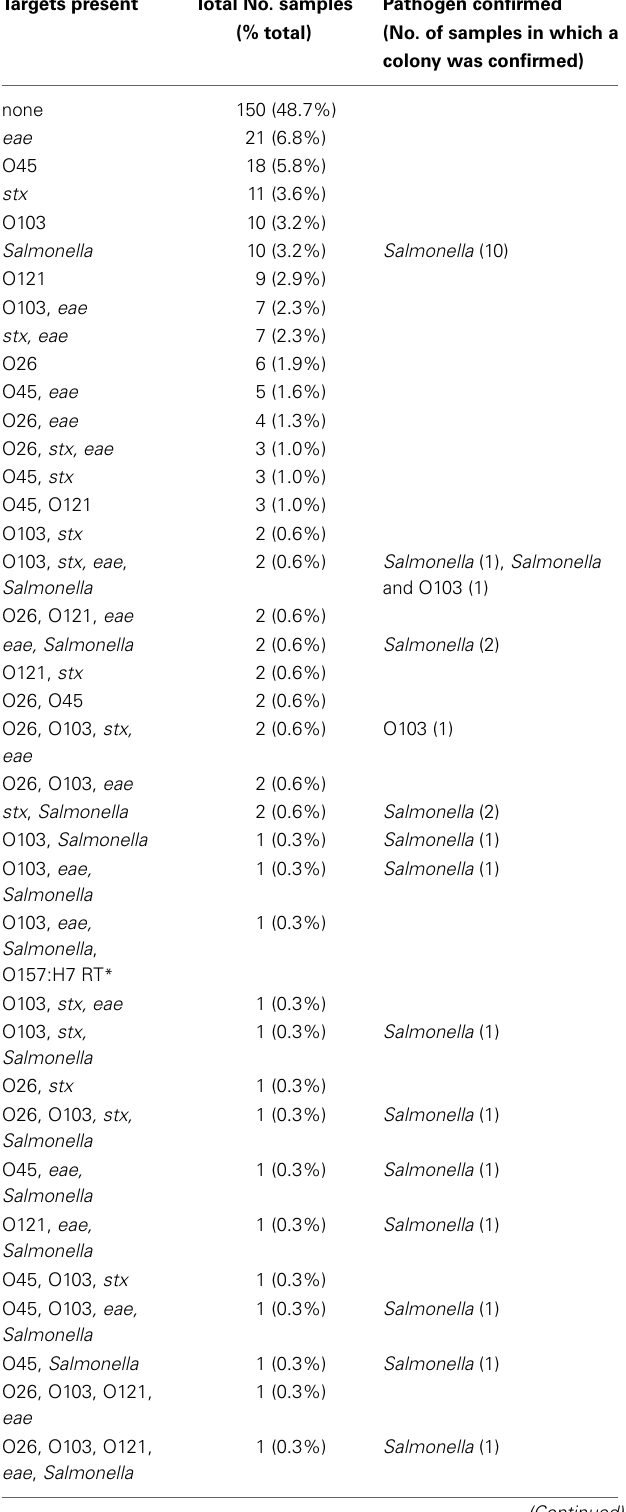
Table 1 | Detection of STEC and Salmonella in 308 retail beef samples using the BAX ® System real-time assays and the number of samples in which a colony was confirmed.